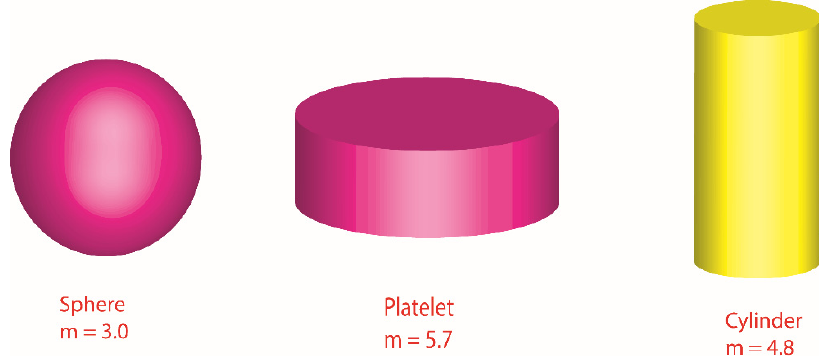
Figure 3. Illustration of various shapes related to nanoparticles.